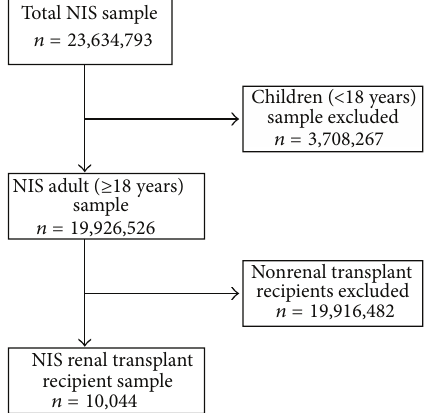
Figure 1: Sample selection procedure in study using Nationwide Inpatient Sample (NIS),